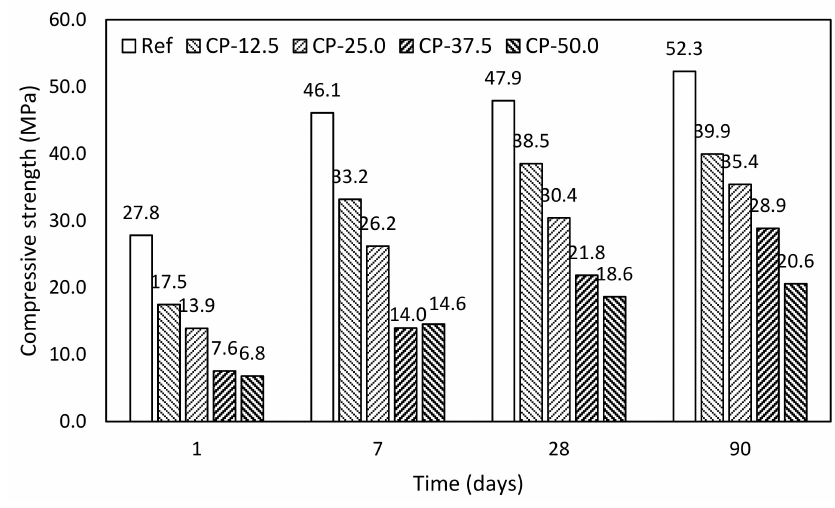
Figure 9. Evolution of compressive strength of mortars with ceramic powder.